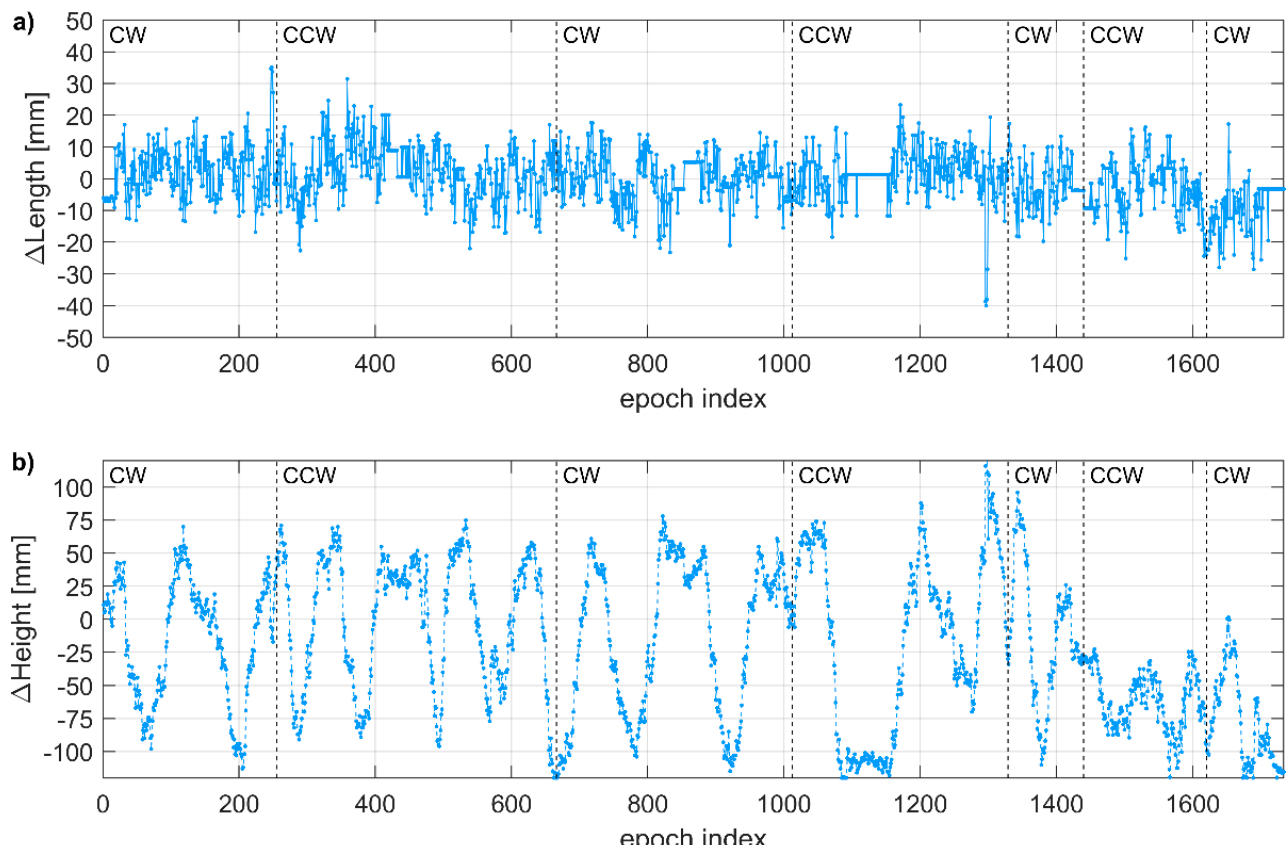
Figure 8. Positioning error in consecutive epochs: ( a ) for baseline length; ( b ) for the height difference. Dashed black lines indicate changes in the rotation direction (CW—clockwise, CCW—coun- ter-clockwise).